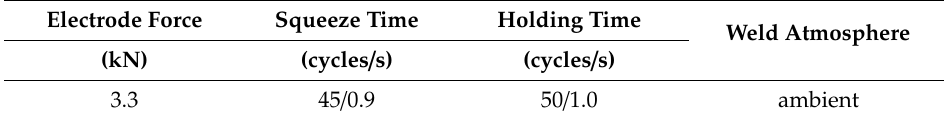
Table 4. Constant welding parameters.